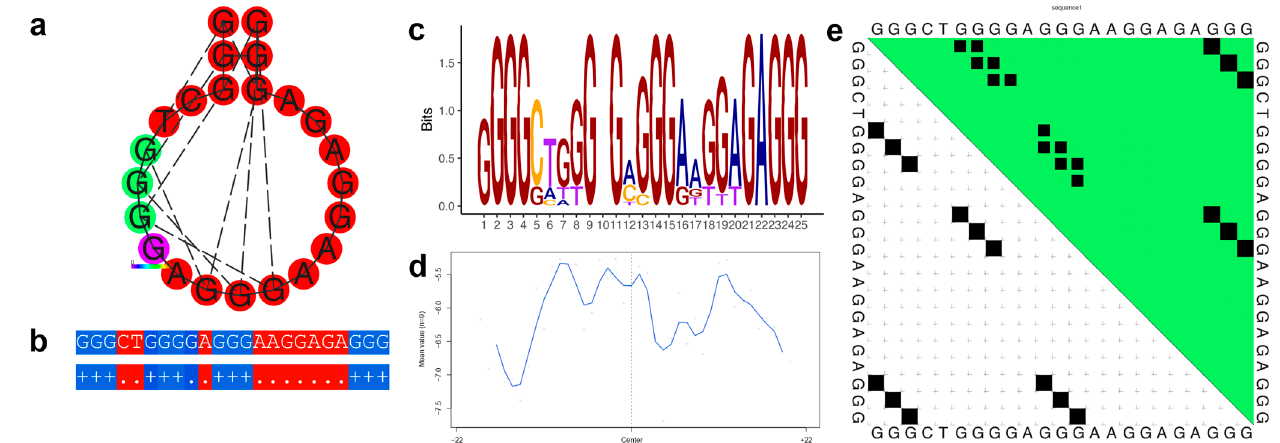
Figure 3. Thermodynamic properties for Family 4. ( a ) Centroid secondary structure with a minimum free energy of − 9.64 kcal/mol using the consensus sequence of the family. ( b ) Dot-bracket notation showing the secondary structure. ( c ) Sequence logo representing the per base information content. ( d ) Electrostatic potential generated from all the sequences of the family using 10 flanking bases on either side of the identified G4. ( e ) Dot plot showing the substructures with the highest probabilities. Family 32 contains 90 G4 sequences annotated with 85 genes. The